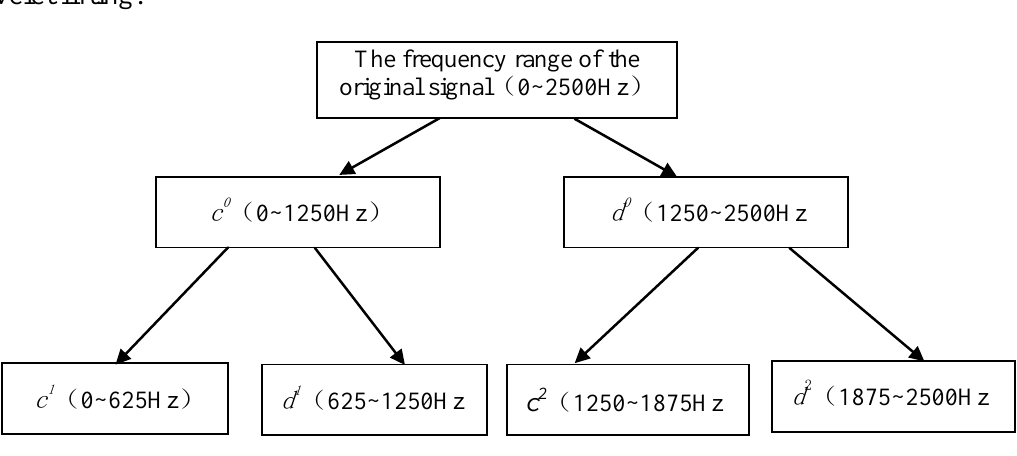
Figure 7. Decomposition of the original signals (the spectrum range 0-2500Hz) through wavelet